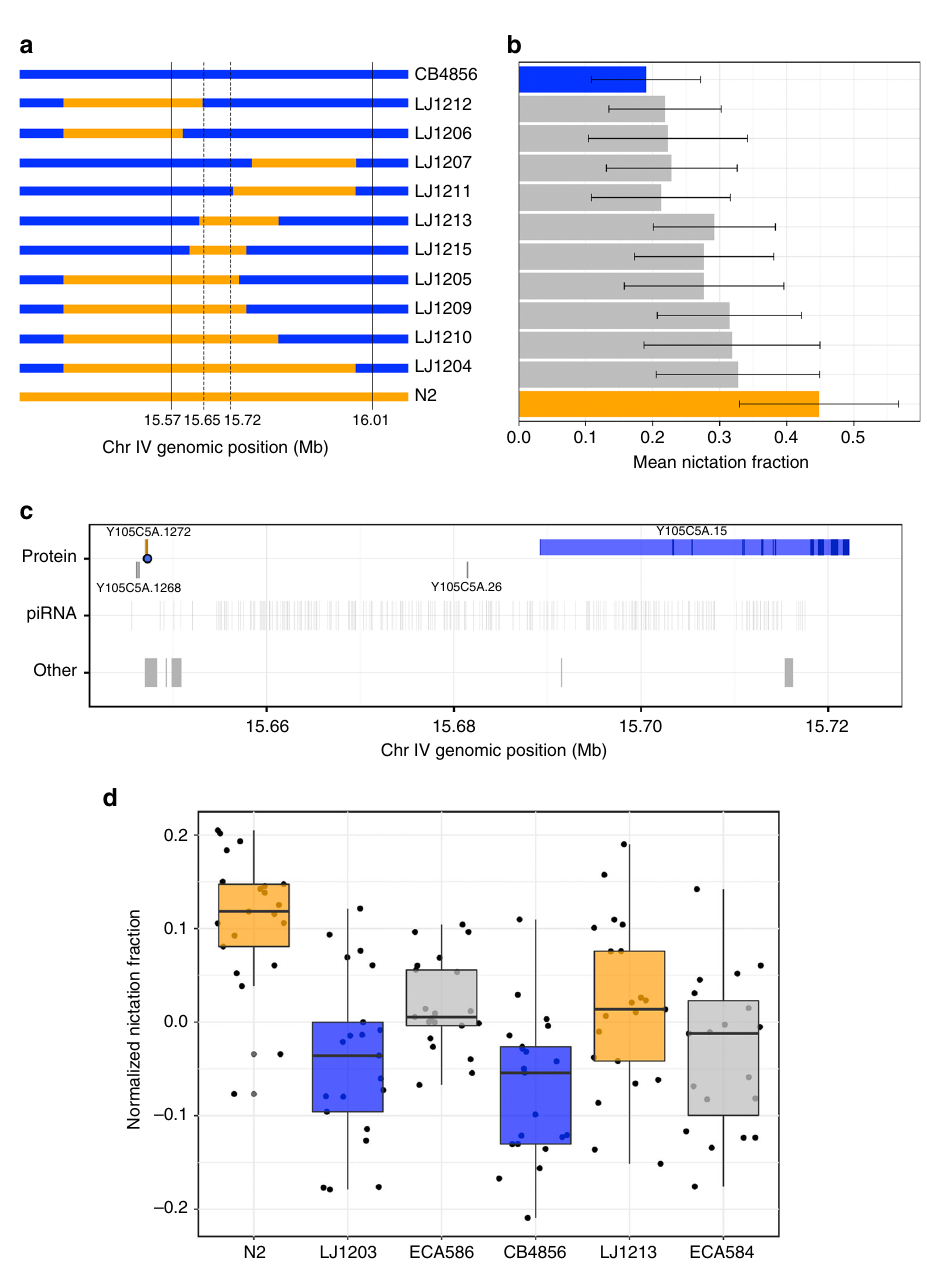
Fig. 2 Variation in 21U piRNAs underlies nictation differences. a Genotypes of near isogenic lines (NILs) represented by orange (N2) and blue (CB4856) colored bars are shown. Strain labels are to the right . Solid vertical lines denote the con fi dence interval from the genetic mapping experiment. Dotted lines denote the narrowed genetic interval. b The mean nictation fractions of N2 ( orange ), CB4856 ( blue ), and NILs are shown as horizontal bars . Error bars are standard deviations. The number of biological replicates for each strain range from 17 to 49. c Genomic features of NIL-narrowed 73 kb nict-1 QTL interval are shown. Protein-coding genes ( top ) are colored orange (higher expression in the N2 nict-1 strain), blue (higher expression in CB4856 nict-1 strain), or gray (no expression difference between the nict-1 genotypes). The blue dot denotes a predicted functional effect in Y105C5A.1272 . The locations of piRNAs and other genomics features (tRNAs, snoRNAs, etc.) are shown in gray in the middle and bottom rows . d Tukey box plots of normalized nictation fractions of N2 ( orange ), LJ1203 ( nict-1 CB4856 > N2, blue ), ECA586 ( prg-1(ean28) in the N2 genetic background, gray ), CB4856 ( blue ), LJ1213 ( nict-1 N2 > CB4856, orange ), ECA584 ( prg-1(ean30) in the CB4856 genetic background, gray ) are shown with data points plotted behind. The horizontal line is the median, and the box denotes the 25th to 75th quantiles of the data. The vertical line represents the 1.5 interquartile range. All strains were scored in 21 biological replicates, except for strain ECA584 where 19 biological replicates were scored. Each biological replicate was composed of three technical Identi fi cation and fi ne mapping of the nict-1 QTL . We sought right arm of chromosome IV (Fig. 1c). This locus does not overlap any of laboratory-derived loci, including npr-1 , glp-5 , and the genetic causes underlying this difference in nictation by nath-10 , that were discovered previously 17 – 20 . Recombinant measuring the behaviors of 186 recombinant inbred advanced strains with the N2 nict-1 genotype exhibited a higher nictation intercross lines (RIAILs) derived from a cross between N2 and ratio compared to those strains with the CB4856 genotype CB4856 (Fig. 1b and Supplementary Data 2). Linkage mapping (Fig. 1d), consistent with the parental difference. revealed a single signi fi cant QTL, which we named nict-1 , on the